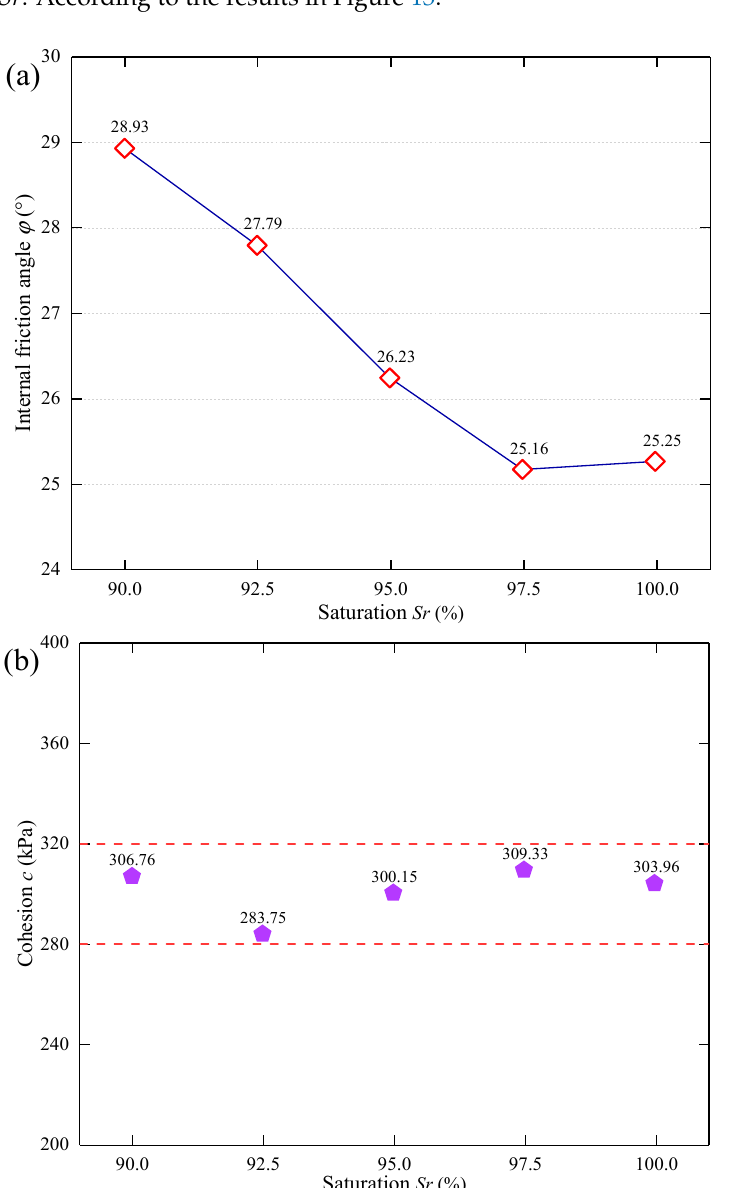
Figure 13. Relationship between strength parameter and saturation of coral sand: ( a ) internal friction angle; ( b ) cohesion.